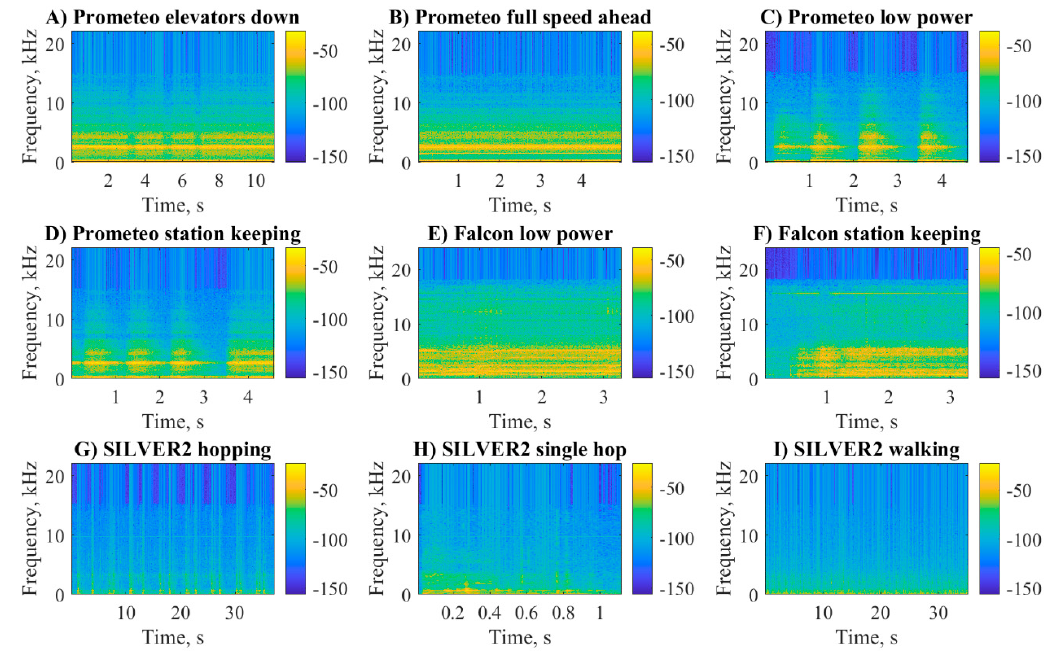
Figure 5. Spectrograms of Prometeo (blue), Falcon (red), and SILVER2 (black) performing various maneuvers. The magnitude of the spectra is color-coded according the color bars to the right of each plot.